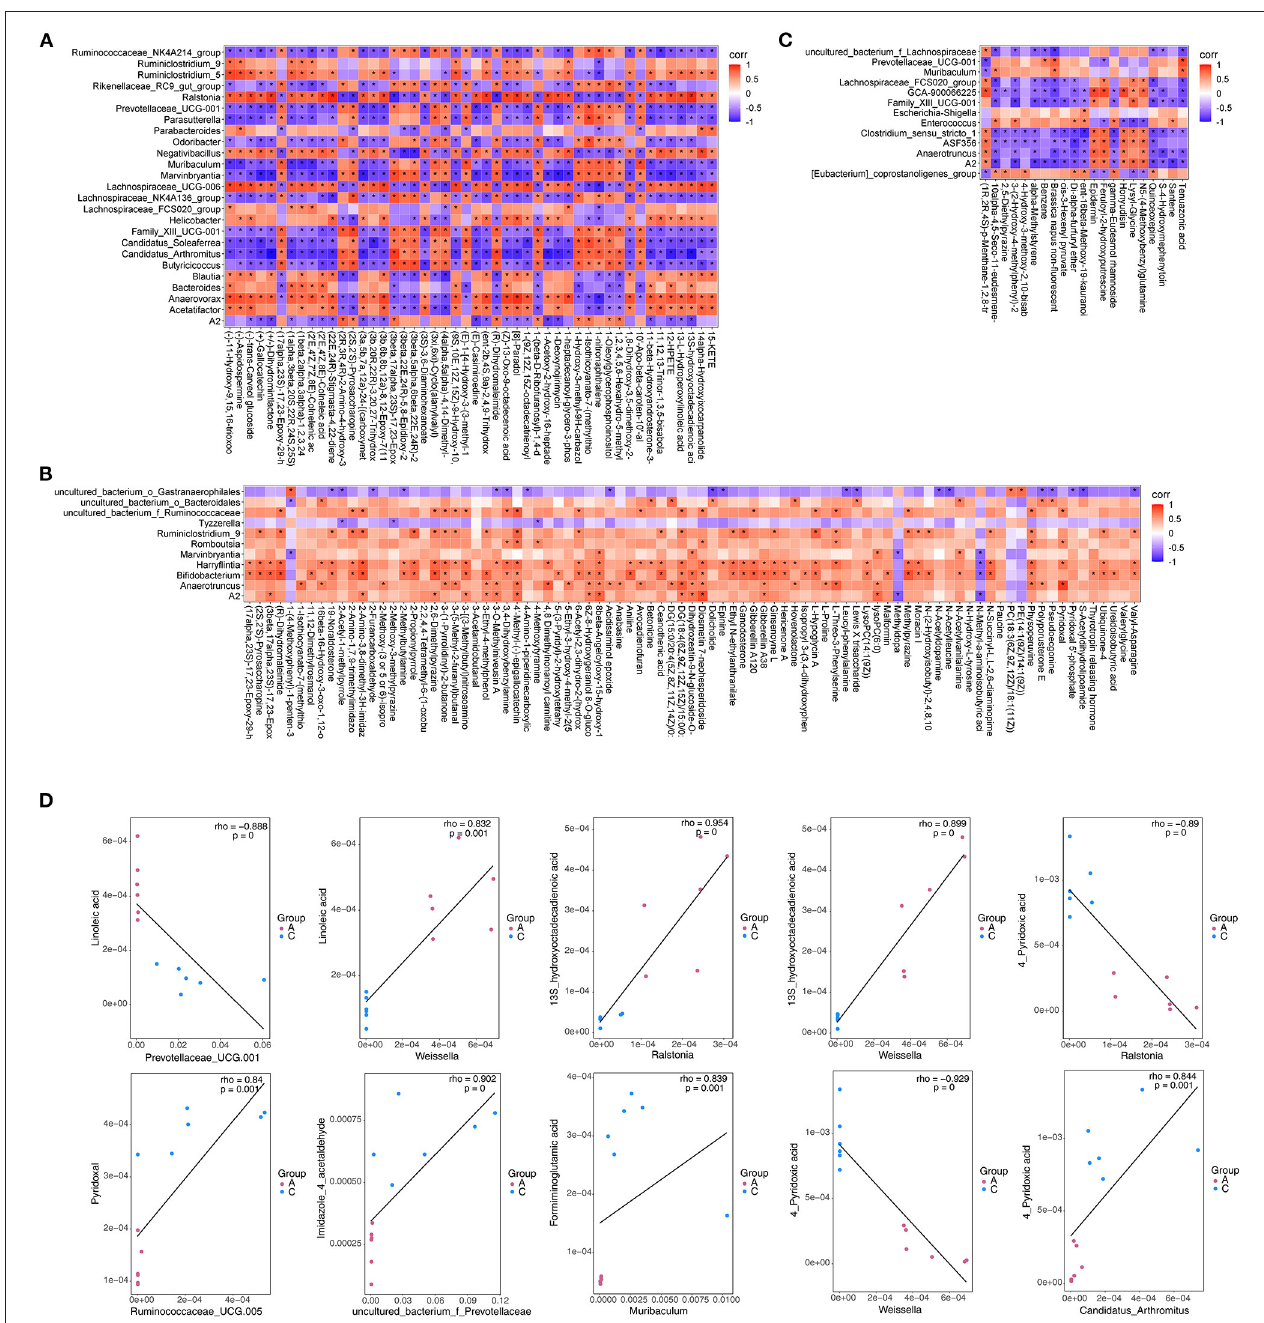
FIGURE 11 | Thermogram of the correlation (A–C) and scatter plot (D) of differentially expressed microflora and differentially expressed metabolites in mouse feces. (A) : Partial screenshots of correlation analysis results between NT-free group and NT intervention group; (B) : correlation analysis results between basal diet group and NT intervention group; (C) : correlation analysis results between basal diet group and model control